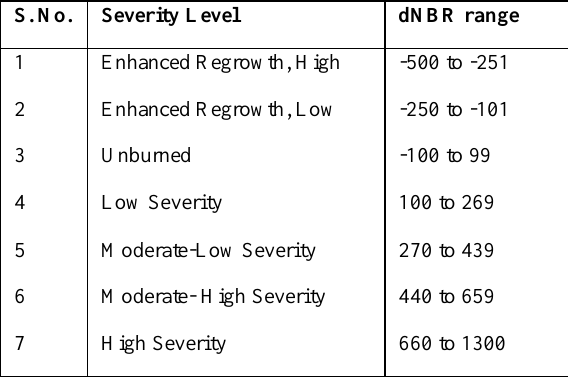
Table 1. Burn severity levels